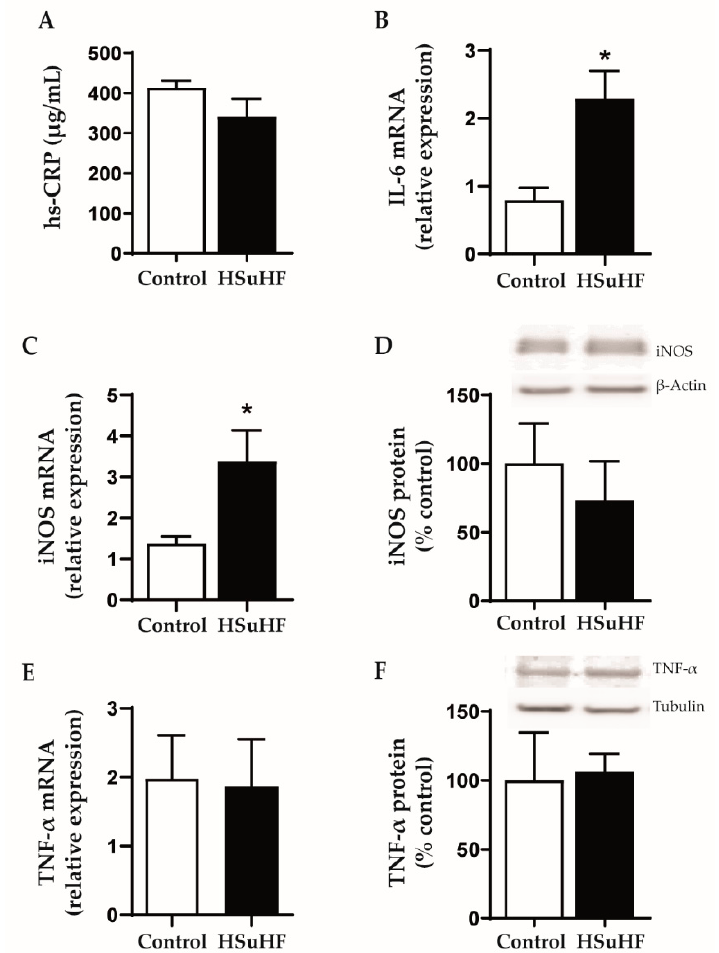
Figure 6. Serum hs-CRP levels ( A ) and kidney expression of IL-6 mRN ( B ), iNOS mRNA ( C ) and protein ( D ), as well as TNF- α mRNA ( E ) and protein ( F ) expression in the Control and HSuHF-treated rats. Values are means ± S.E.M. of n = 8 per group (except for western blotting: n = 6 per group), and were expressed as relative expression (for mRNA) in relation to two housekeeping genes used (GAPDH and HPRT) and as % of control (for protein). * P < 0.05.